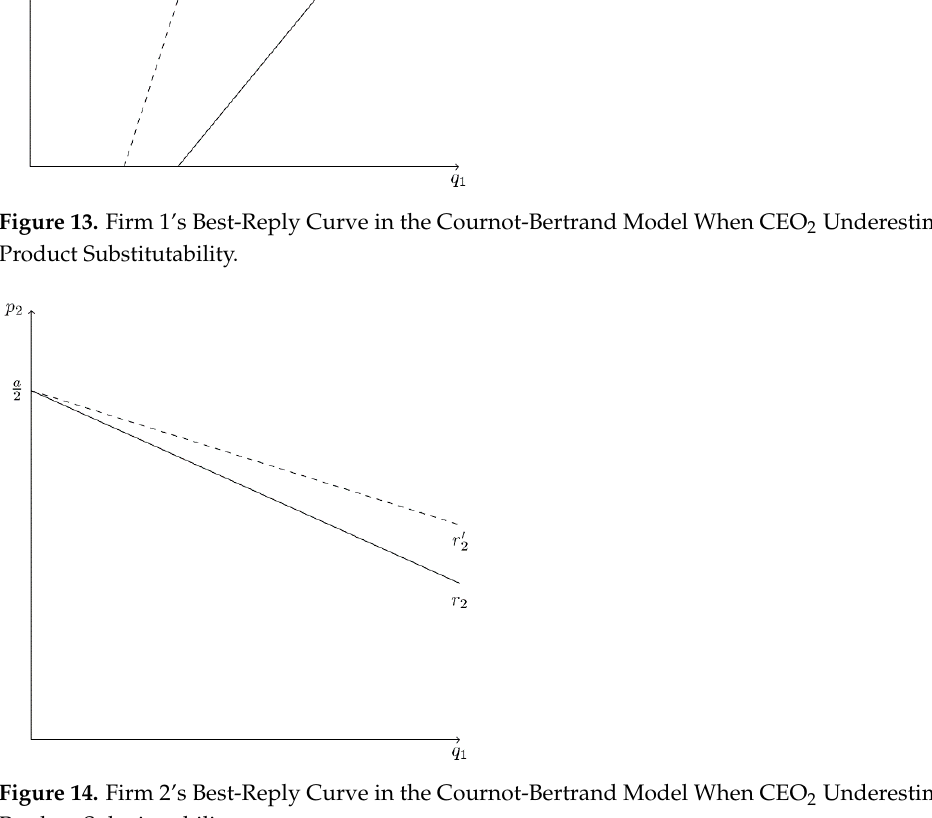
Figure 13. Firm 1’s Best ‐ Reply Curve in the Cournot ‐ Bertrand Model When CEO 2 Underestimates Product Substitutability.